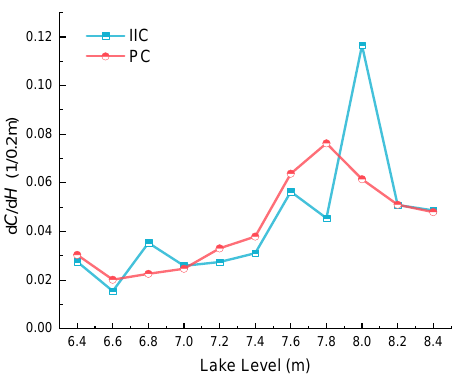
Figure 9. Variation of the increased rates of connectivity with increased lake levels ( dC / dH ).